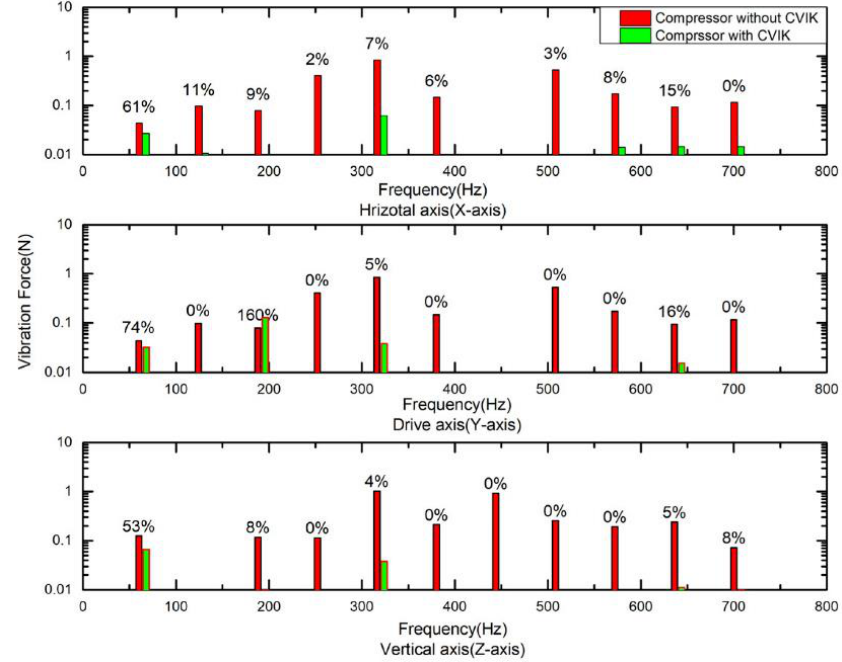
Figure 5. Comparison of compressor vibration level with and without an isolation system.